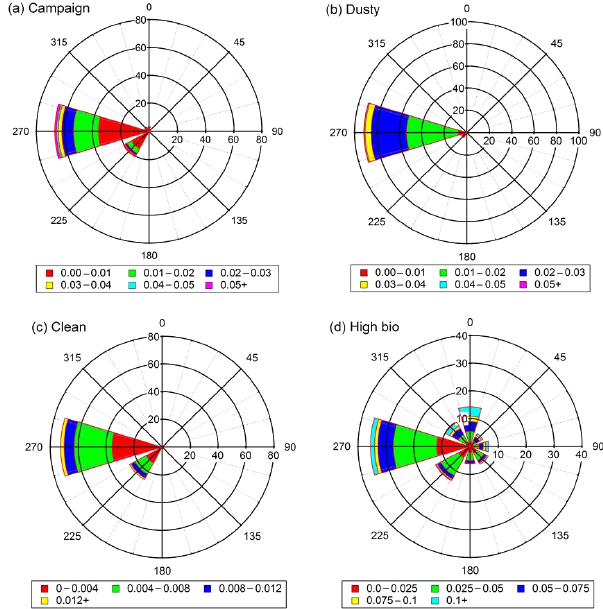
Figure 12. Wind rose diagram scaled over FBAP number concen- tration ( N F ) . These diagrams in a way are similar to the traditional wind rose diagram, except that they represent the N F in this case in- stead of wind speed. These diagrams can be nominally interpreted as follows: for example, (a) shows that ∼ 52% of the frequency of occurrence of N F concentrations in the range of 0–0.01cm − 3 was associated with westerly/southwesterly winds and, by contrast, (d) indicates that out of ∼ 18% of the frequency of occurrence of high concentrations ( N F >0.1cm − 3 ) , ∼ 16% was associated with northerly/northwesterly winds. (a) Entire campaign, (b) dusty pe- riod, (c) clean period, and (d) high bio period. Note that the non- uniform scale of each panel has a unit of cm − 3